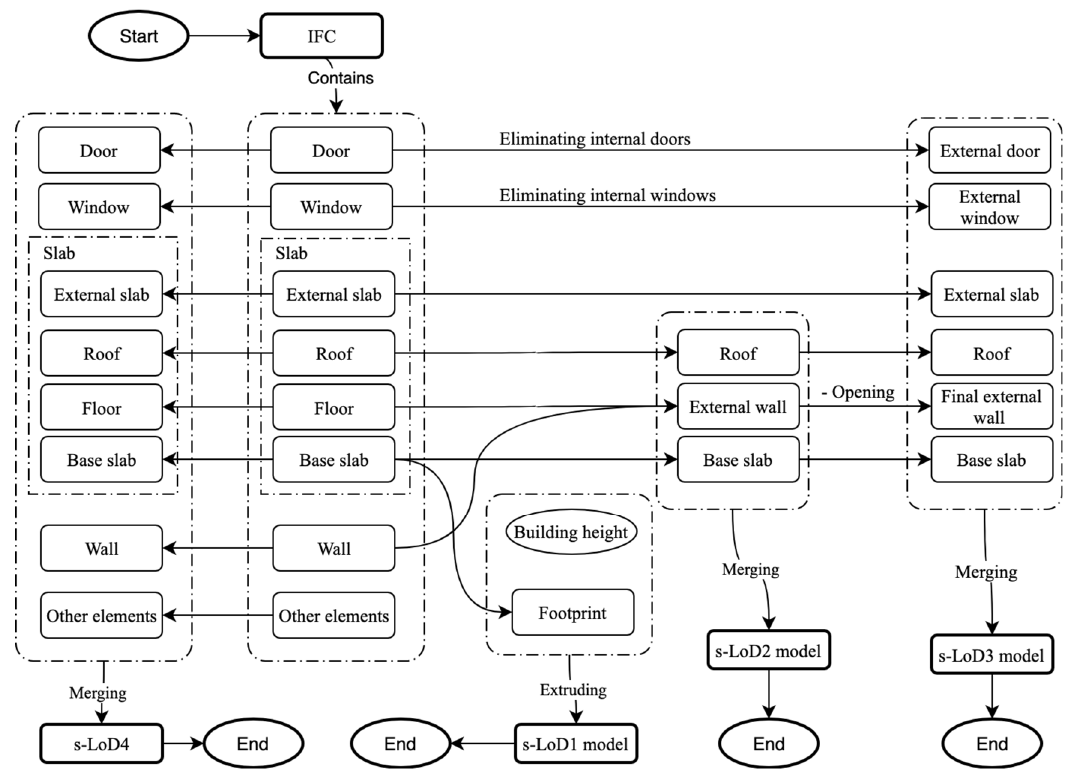
Figure 5. Workflow for generating s-LoD1 to s-LoD4 models. Table 3. Industry Foundation Classes (IFC) building elements with the “IsExternal” attribute.